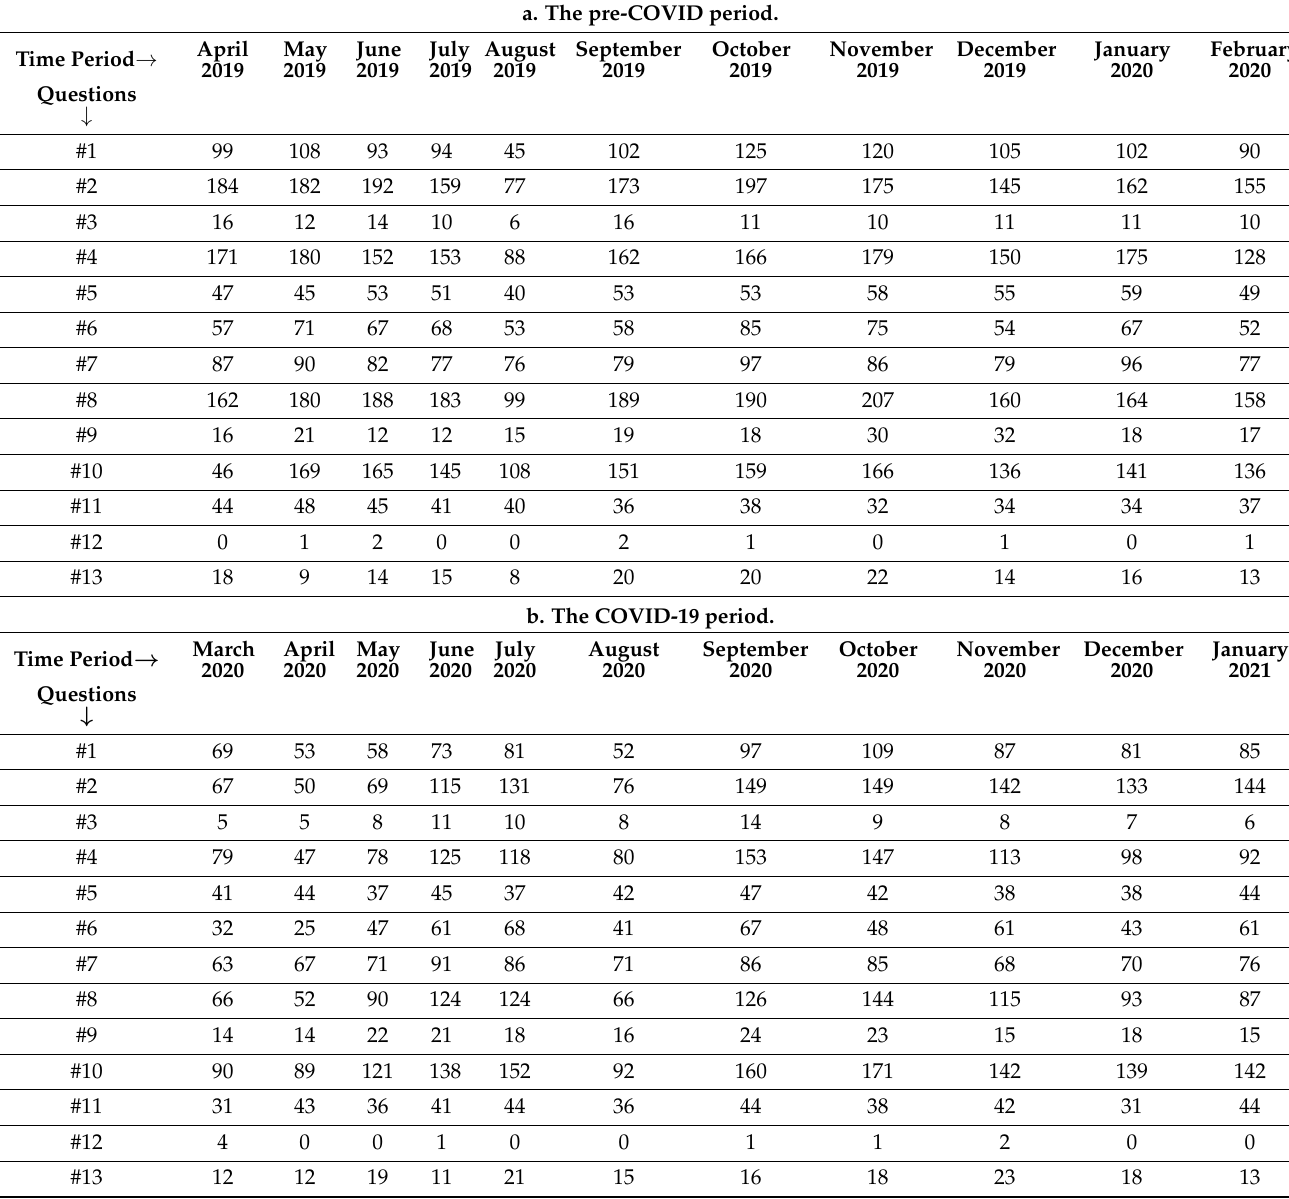
Table 1. Summary of the responses to the questionnaire. a. The pre-COVID period.